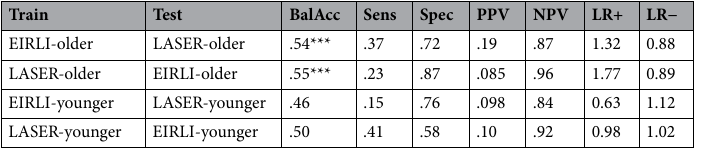
Table 2. Model performance for external validation, training and testing on separate